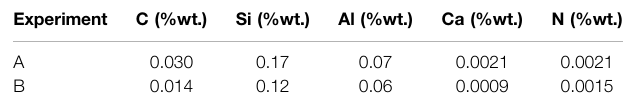
TABLE 2 | Concentration of elements of interest in the steel puck after each